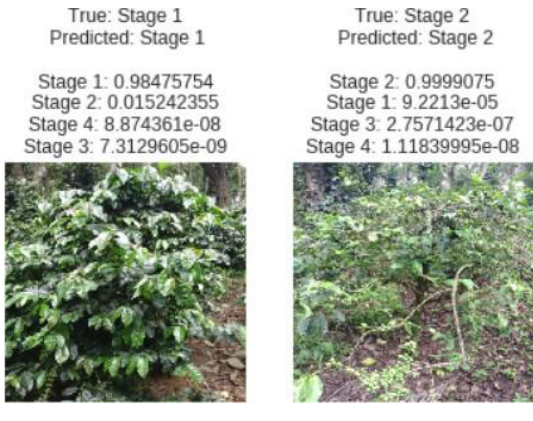
Figure 13. Ranked Stage Predictions on Raw Images